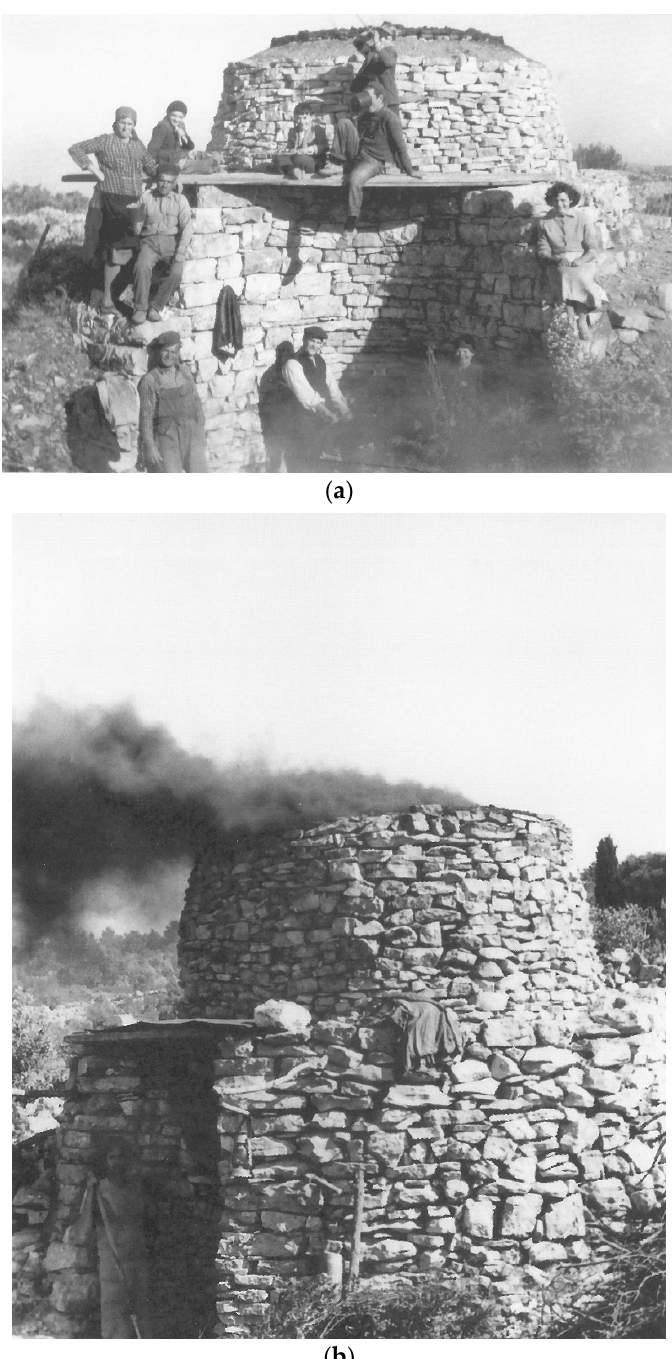
Figure 5. Lime kilns on Šolta Island from mid-20th century: ( a ) a kiln under construction; ( b ) a kiln in which a fire has been lit.